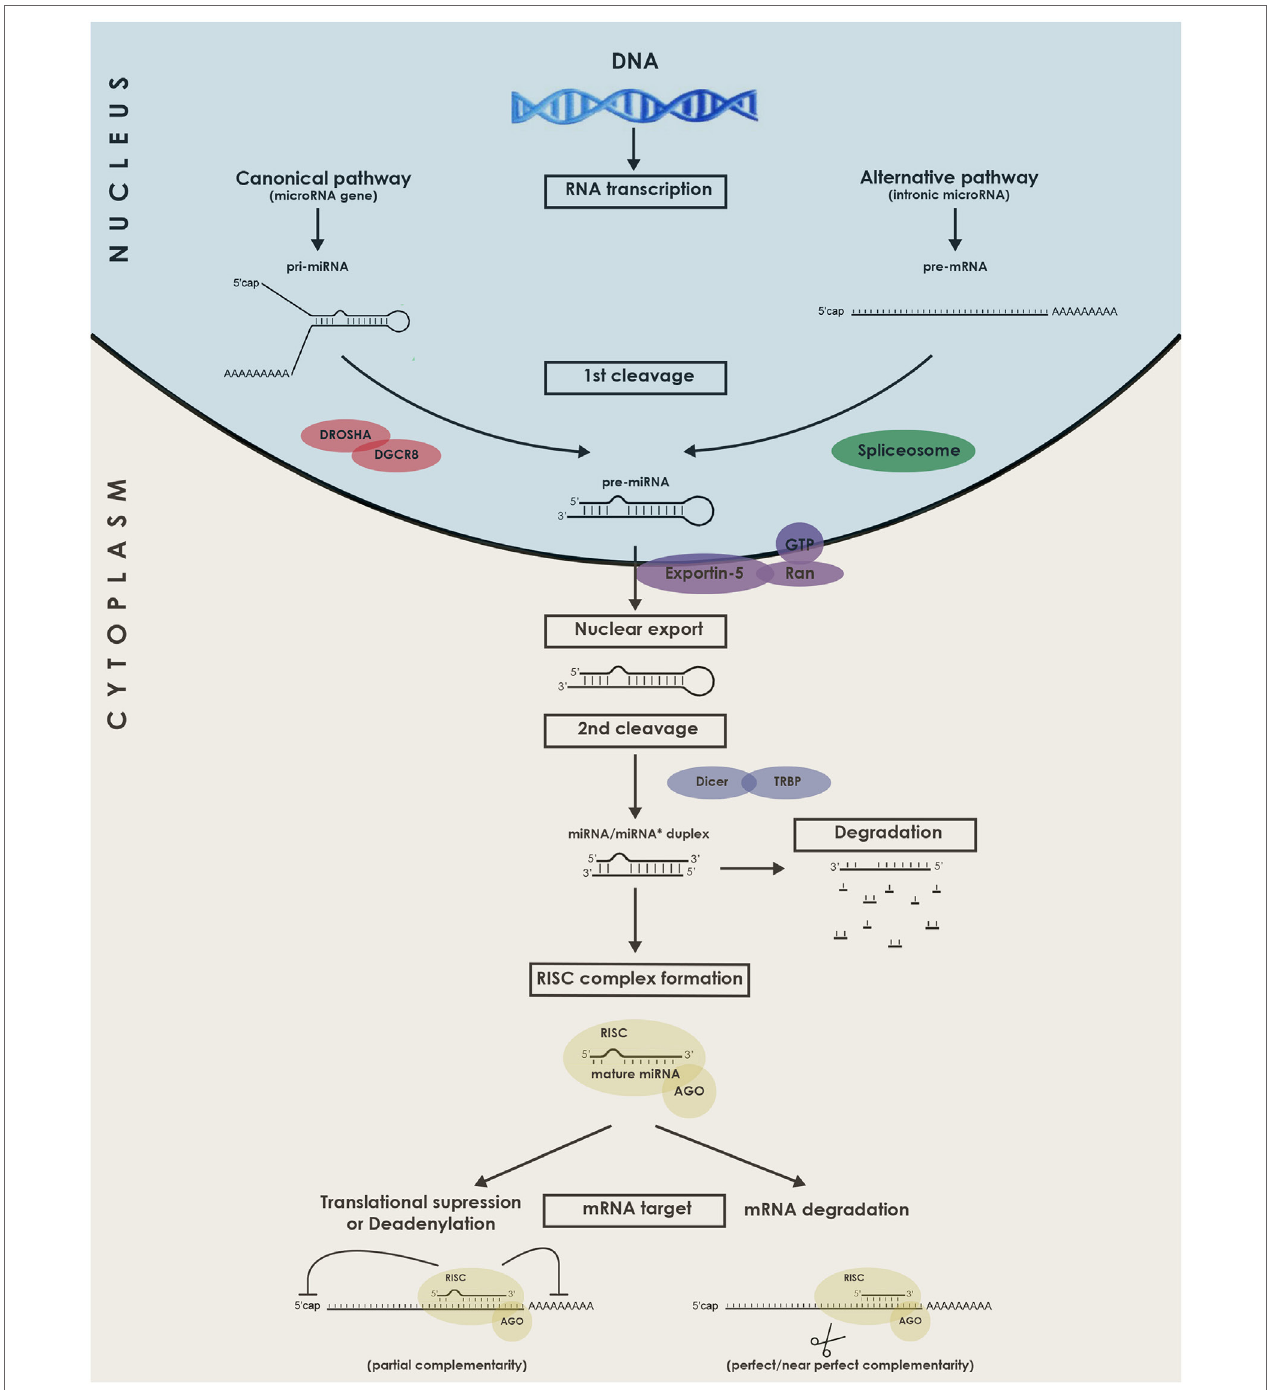
FigURe 1 | Schematic representation of the biogenesis and functions of microRNAs (miRNAs). miRNAs genes are transcribed in the nucleus by RNA Polymerase II as long pri-miRNA transcripts that are 5 ′ capped and 3 ′ polyadenylated. The pri-miRNA sequence folds into a hairpin loop structure that is recognized and processed by the microprocessor complex Drosha-DGCR8, generating a pre-miRNA (Canonical pathway). Mirtrons, a class of unconventional miRNAs are encoded in small introns and do not require Drosha processing (alternative pathway). In this alternative pathway, the intron lariat is excised by the spliceosome and refolded into a pre-miRNA hairpin loop. The pre-miRNA is then exported from the nucleus to the cytoplasm by exportin 5, where it is further cropped by Dicer in complex with TRBP, yielding a ~21–23 nucleotides double-stranded RNA called miRNA/miRNA* duplex. Next, the functional mature miRNA (miR) is loaded together with AGO proteins into the RISC complex, guiding RISC to silence by Watson–Crick complementarity a target mRNA through translational repression, deadenylation process, or degradation. DGCR8, DiGeorge syndrome chromosomal (or critical) region 8 subunit; TRBP, TAR RNA binding protein; AGO, Argonaute; RISC, RNA-induced silencing complex.